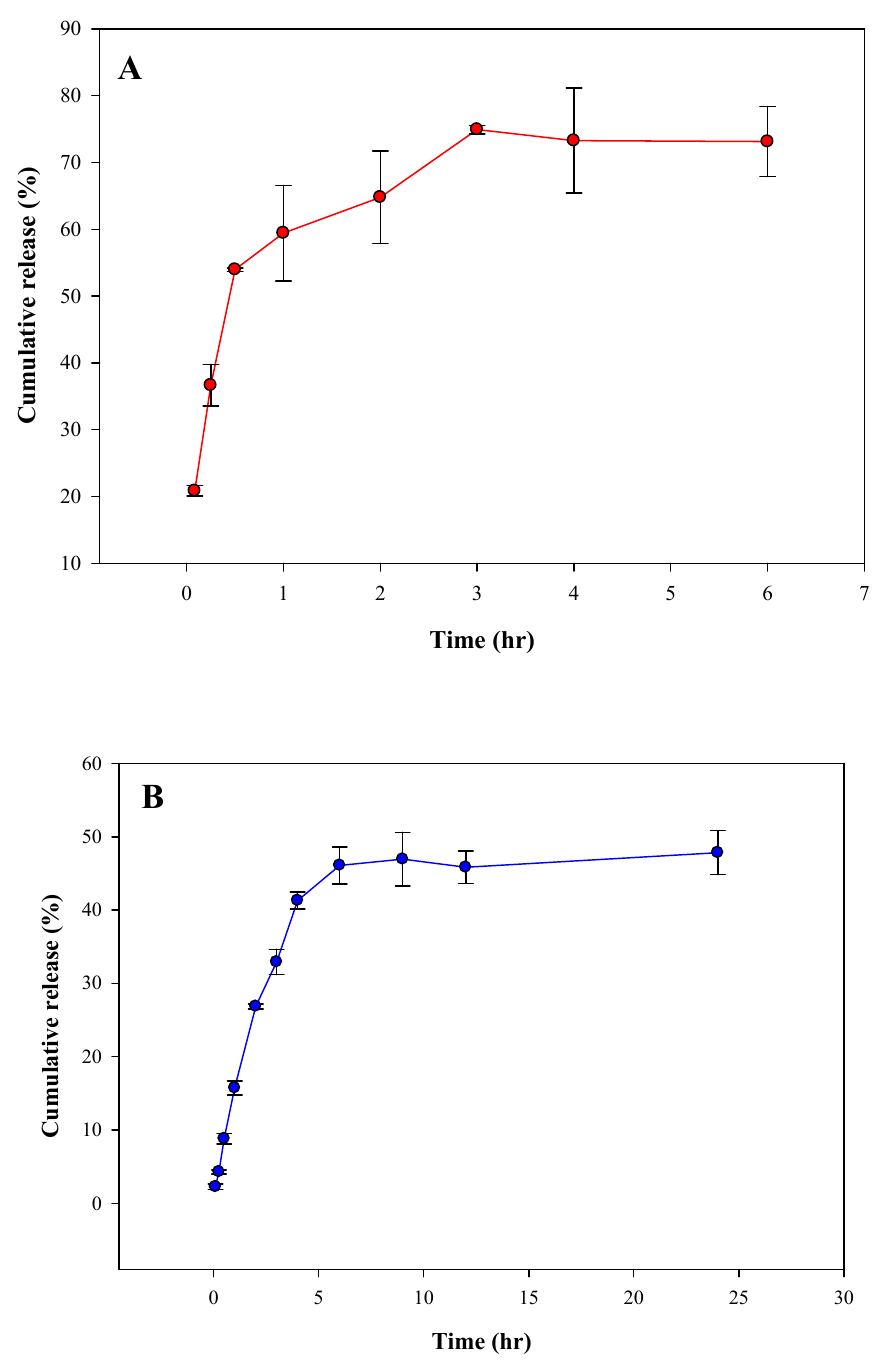
Figure 7. Cumulative percent release profile for ( A ) control beaded fibers over a period of 6 h and ( B ) MI beaded fibers over a period of 24 h.